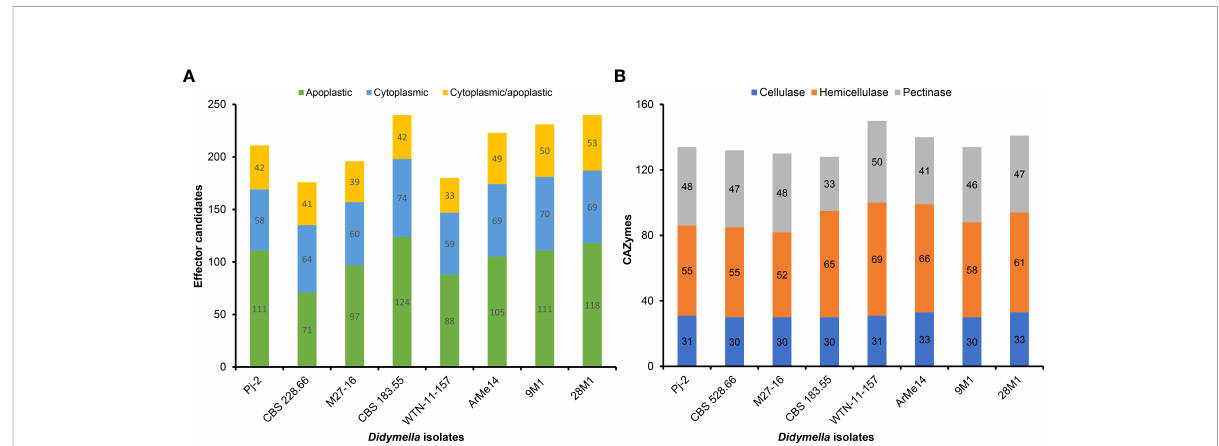
FIGURE 1 Distribution of effector candidates (A) and carbohydrate-active enzymes (CAZymes; B ) in eight strains representing six Didymella spp. ( Didymella glomerata Pj-2, CBS 528.66 and M27-16, D. pinodes WTN-11-157, D. keratinophila 9M11, D. heteroderae 28M1, D. exigua CBS 183.55 and Ascochyta [ Didymella ] rabiei